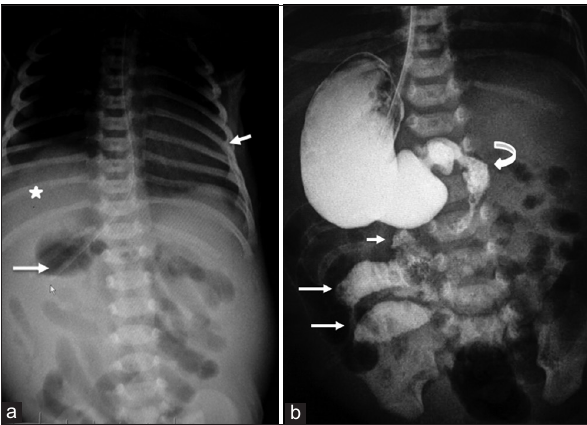
Figure 1: (a) Infantogram showing levocardia (short arrow) and the nasogastric tube, leading to a fundal gas shadow (long arrow) in the right upper abdomen below the liver